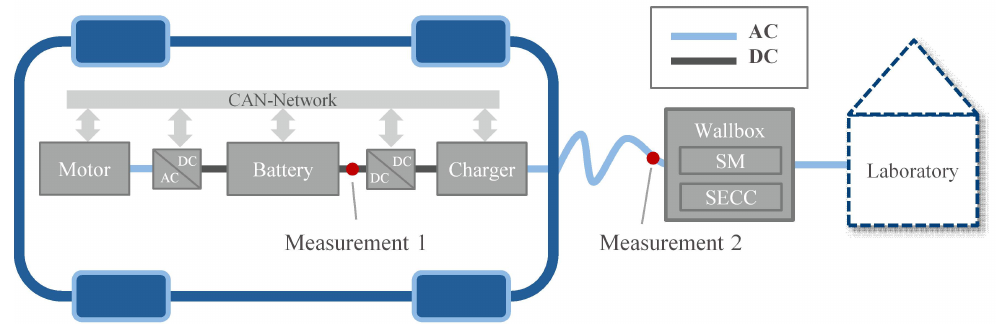
Figure 5. Laboratory setup for charger efficiency